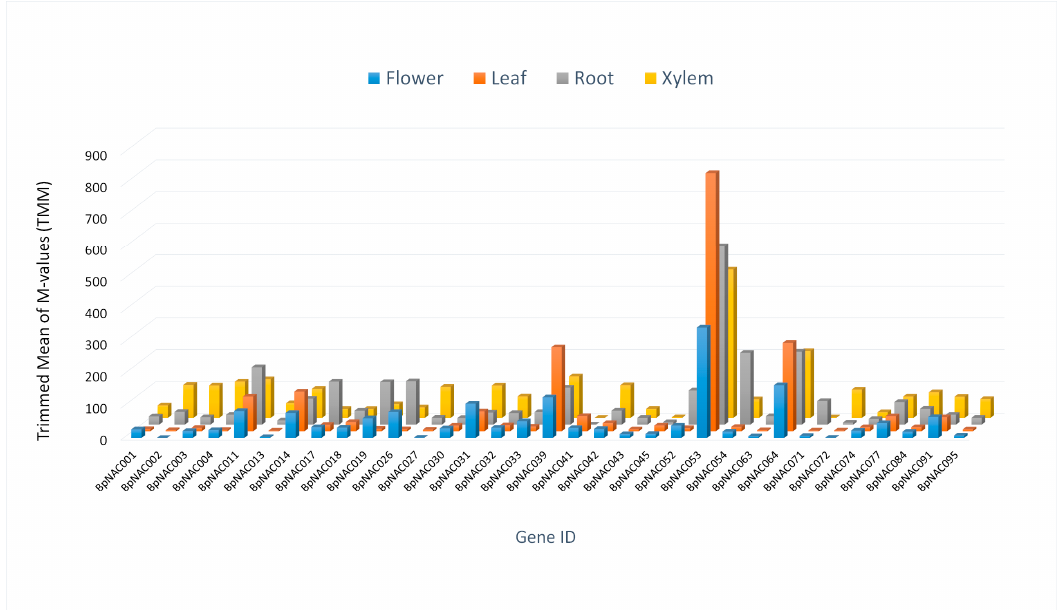
Figure 2. Tissue-specific expression profiles of BpNACs . Only genes with an average TMM value larger than 10 are shown.